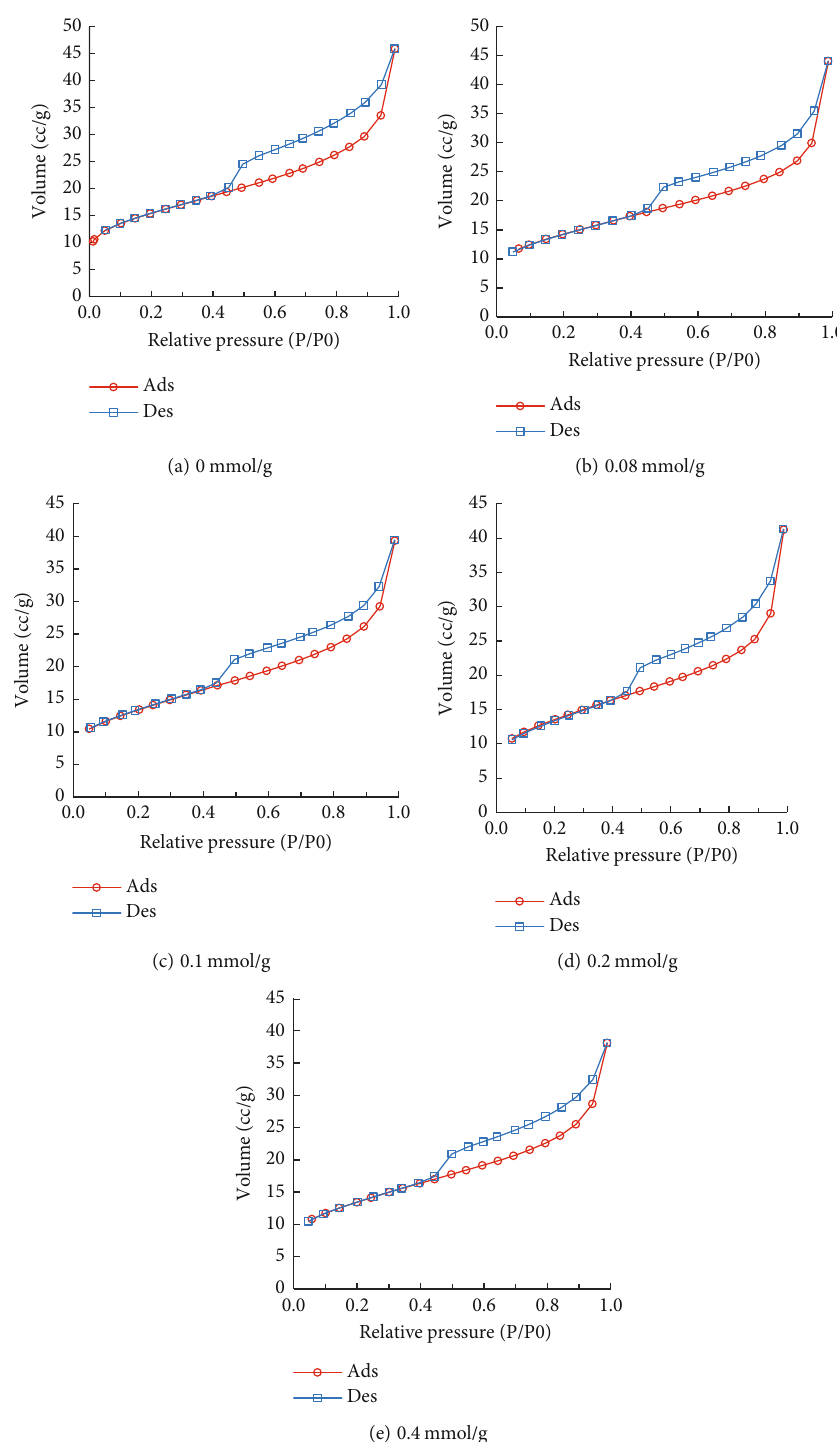
Figure 14: N2 adsorption-desorption isotherms with di ff erent amounts of hydroxyl